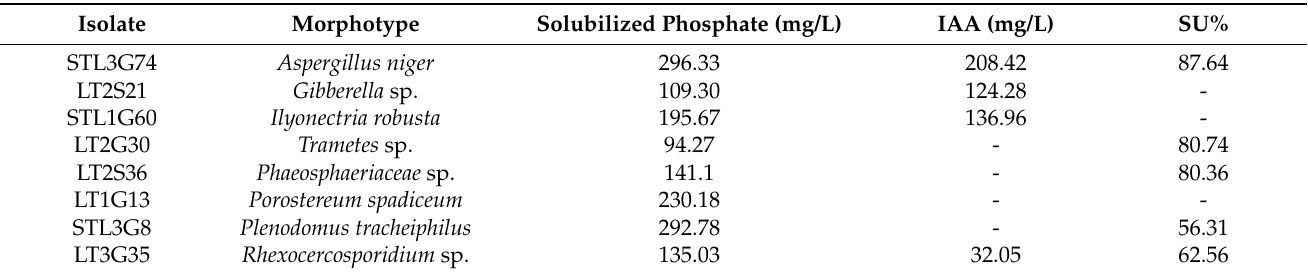
Table 1. The isolates used in pot experiments and their plant growth promoting